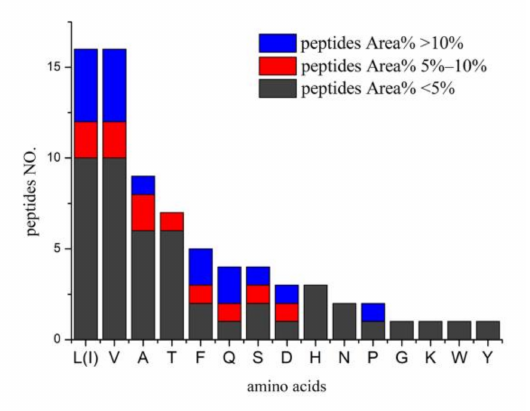
Figure 3. Amino acids compositions of peptides from DB hydrolysates. The vertical axis represent the number of peptides containing the amino acids (horizontal axis), L(I) leucine(isoleucine), V (valine), A (alanine), T (threonine), F (pheylalanine), Q (glutmine), S (serine), D (aspartic acie), H (histidine), N (asparagine), P (proline), G (glycine), K (lysine), W (tryptophan), and Y (tyrosine). Fr1 is the main fraction of DB hydrolysate (47% of the total weight), in which AQ and VQ are major components (Figures 1 and 4; Table 2). Glutamine and alanine are well-known glycogenic amino acids in animals and humans [21], and glutamine is also a direct stimulator of glycogen synthesis via the activation of glycogen synthetase [22,23]. Dipeptide AQ has been widely used as a commercial supplement to increase glutamine availability. It is reported that dipeptides and tripeptides are absorbed across the intestinal epithelium in their intact form via a more efficient mechanism than that of free amino acids [24,25]. Both glutamine and alanyl-glutamine significantly increase glycogen storage in exhaustive swimming rats but have no effects on plasma ammonia [26] or lactic acid accumulation [27]; this agrees with the result that Fr1 significantly increased HG but had no effects on MLA and BUN levels. Thus, the strong effects of Fr1 on improving exercise endurance are likely to be attributed to AQ and VQ through increased HG